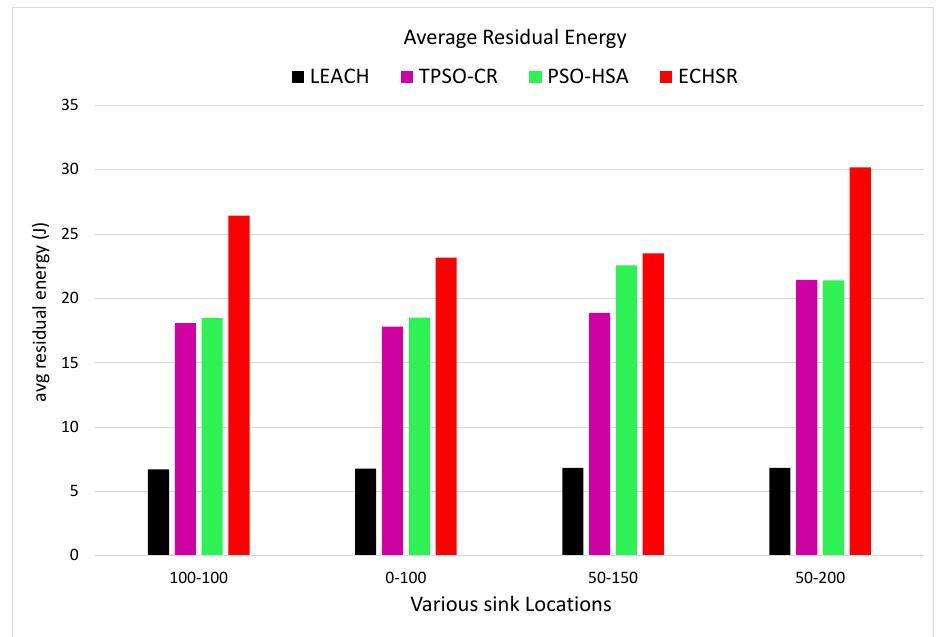
Figure 9. The average residual energy along with various sink